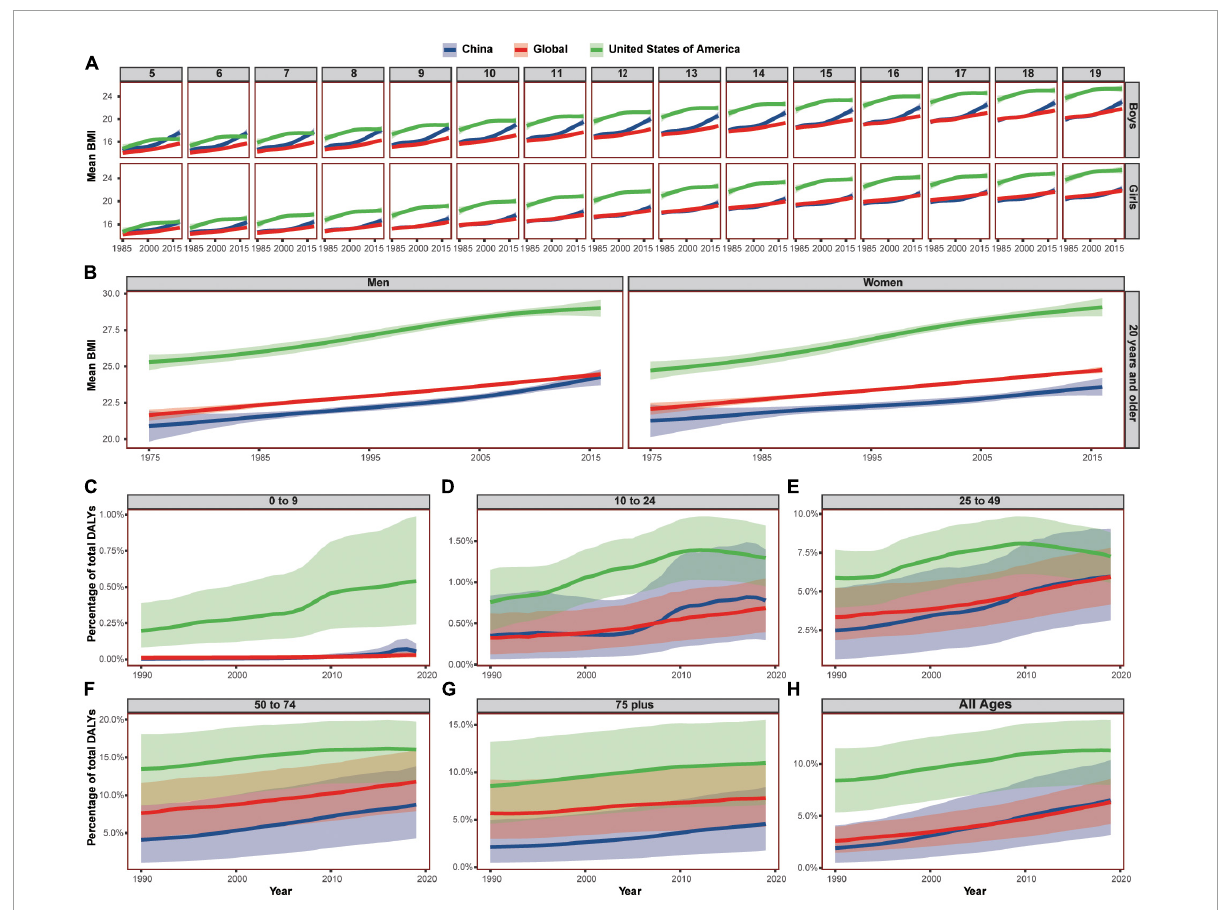
FIGURE5 The trend of BMI and BMI-induced DALYs in China, the United States of America, and the world, by age and sex group. (A) Showed the BMI of adolescent aged from 5 to 19, (B) showed the BMI of adults over 20 years old. (C–H) Showed the DALYs induced by high BMI in different age groups. Shaded sections indicate 95% uncertainty intervals. BMI, body mass index; DALYs, disability-adjusted